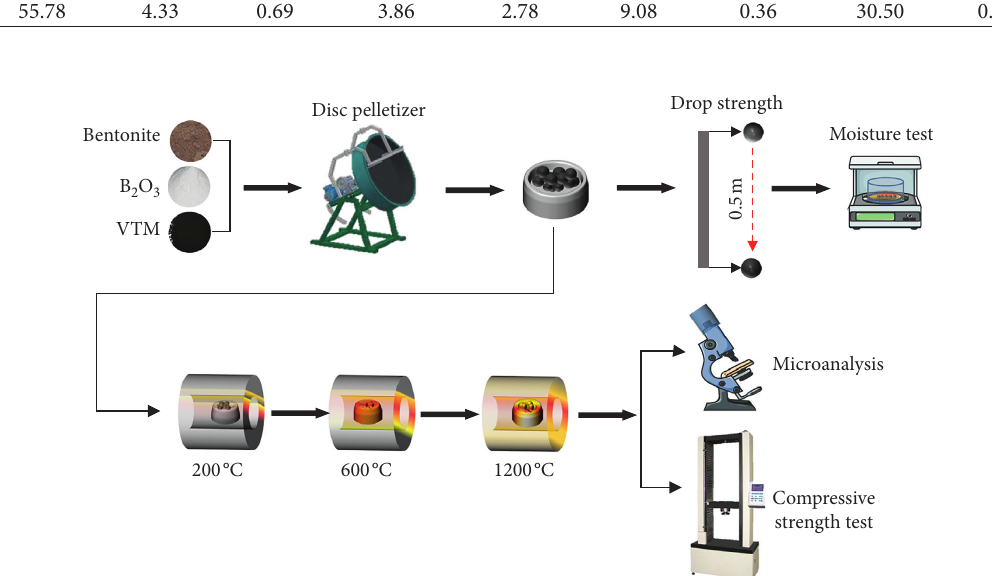
Figure 1: Flowchart of pellets